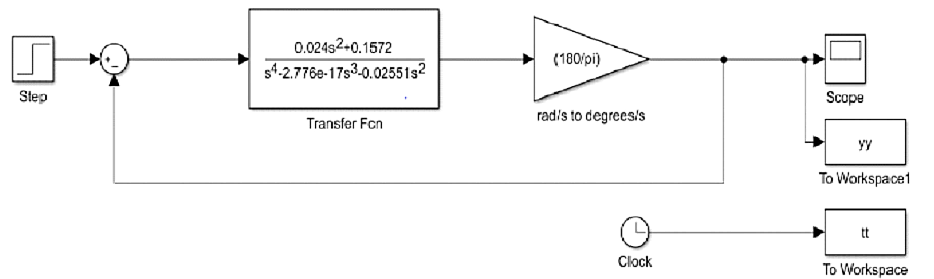
Figure 11. System simulation without PID